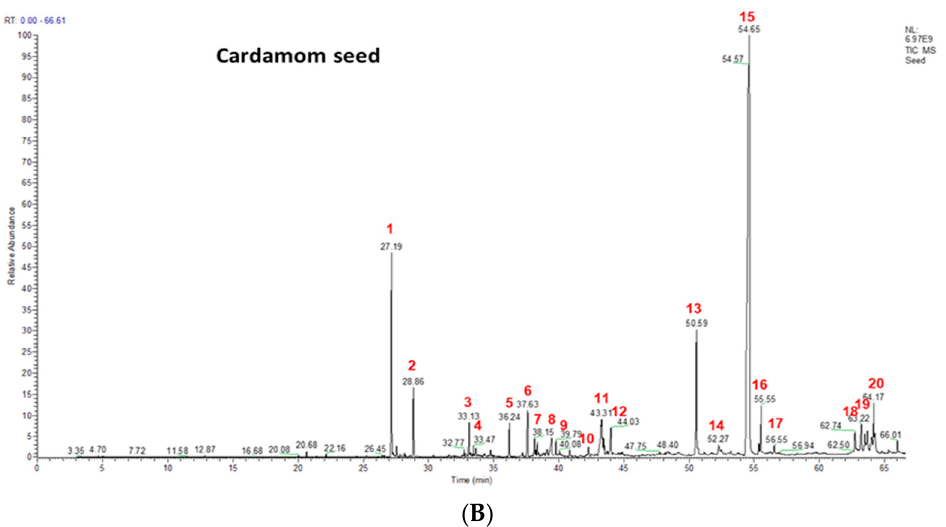
Figure 1. Phenolic and terpenoid profiles of cardamom seeds: ( A ) LC chromatograms of a methanolic extract of cardamom seed and peak assignment in blue of the identified phenolic compounds presented in Table 1; ( B ) GC-MS profiles of volatile compounds of cardamom seeds obtained by steam distillation and peak assignment in red of the identified volatile compounds presented in Table 2.